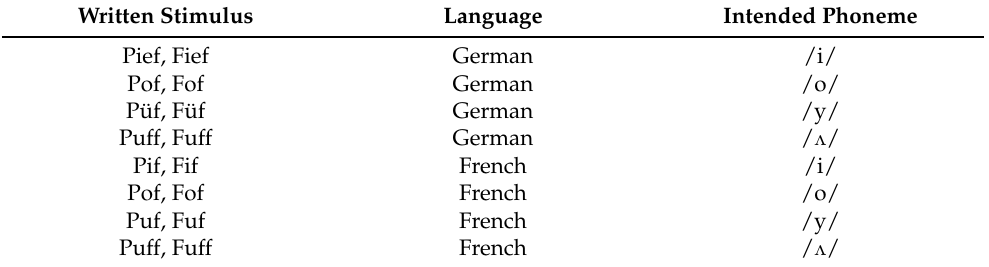
Table 1. Written stimuli used to elicit the auditory stimuli from the native German and French speakers.